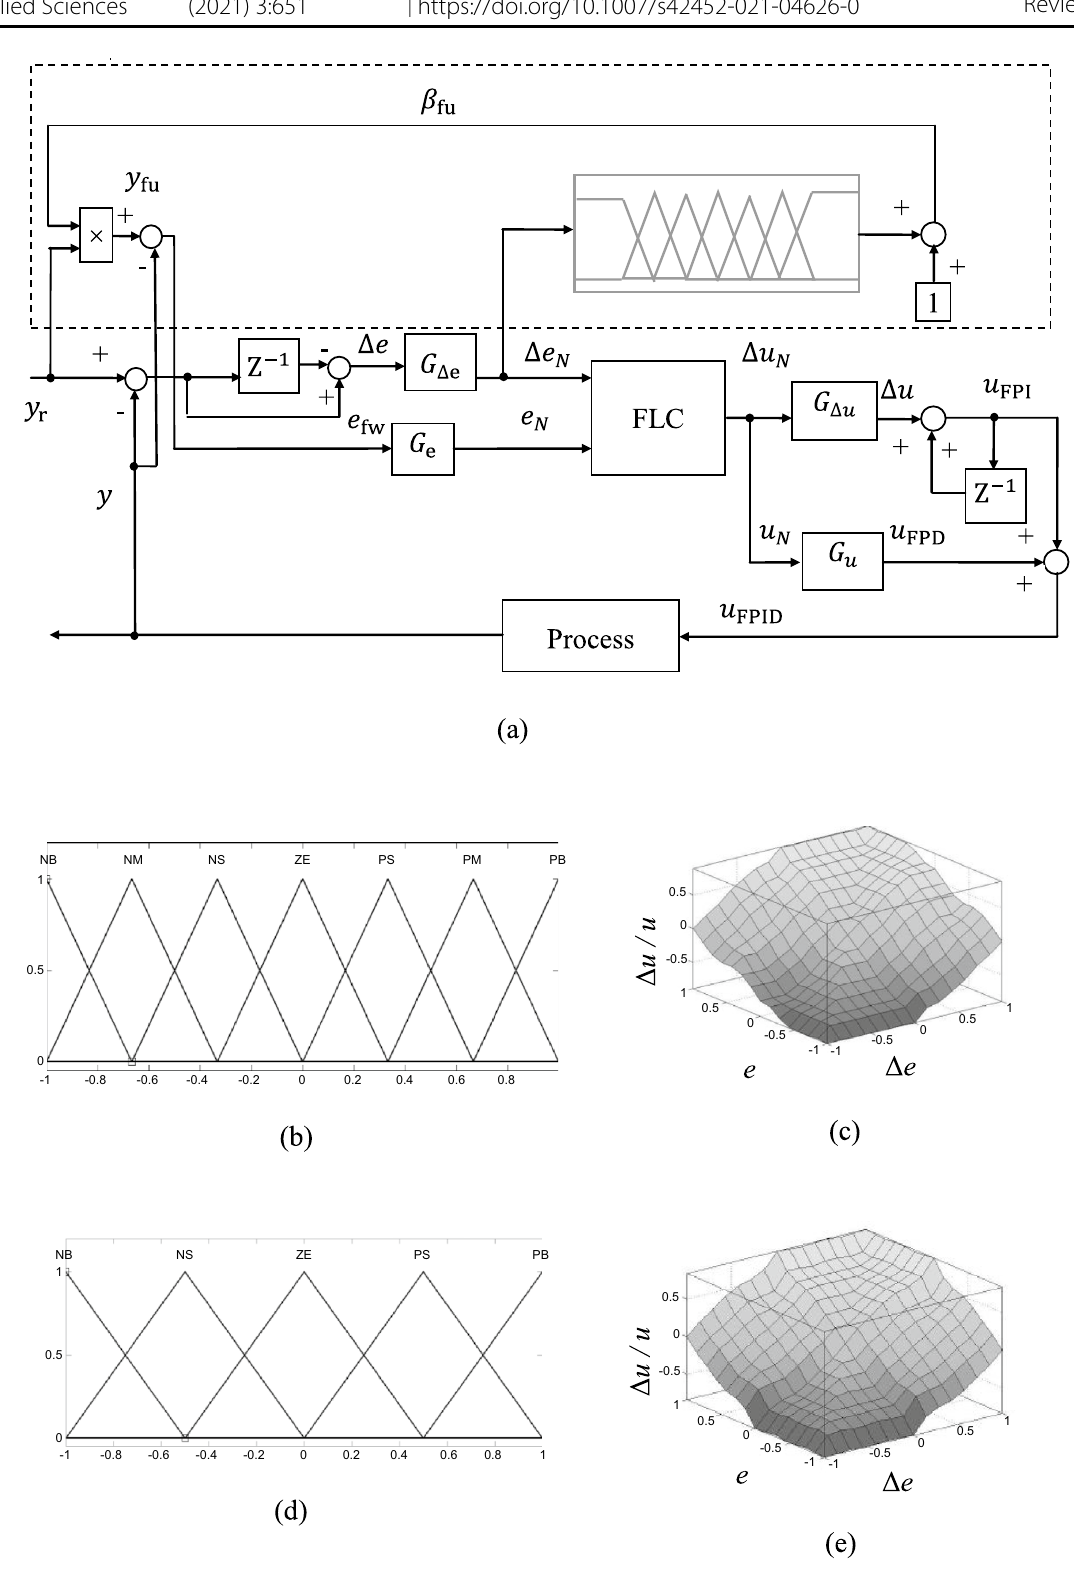
Fig. 1 a Block diagram of the proposed fuzzy PID controller with fuzzy set point weighting (FSWFPID) b 7 MFs for input ( e N , Δ e N ) and output ( u N , Δ u N ) variables c Control surface with 49 rules d 5 MFs for input ( e N , Δ e N ) and output ( u N , Δ u N ) variables e Control surface with 25